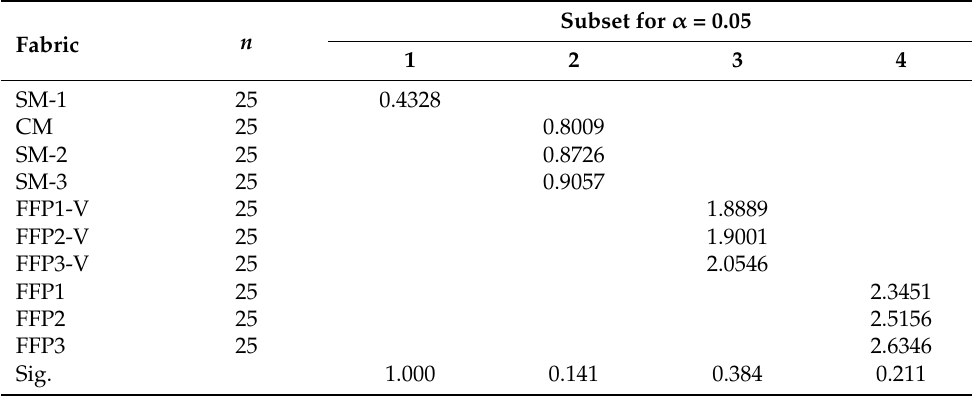
Table 5. The results of SNK post hoc tests of the water vapor resistance values. Fabric